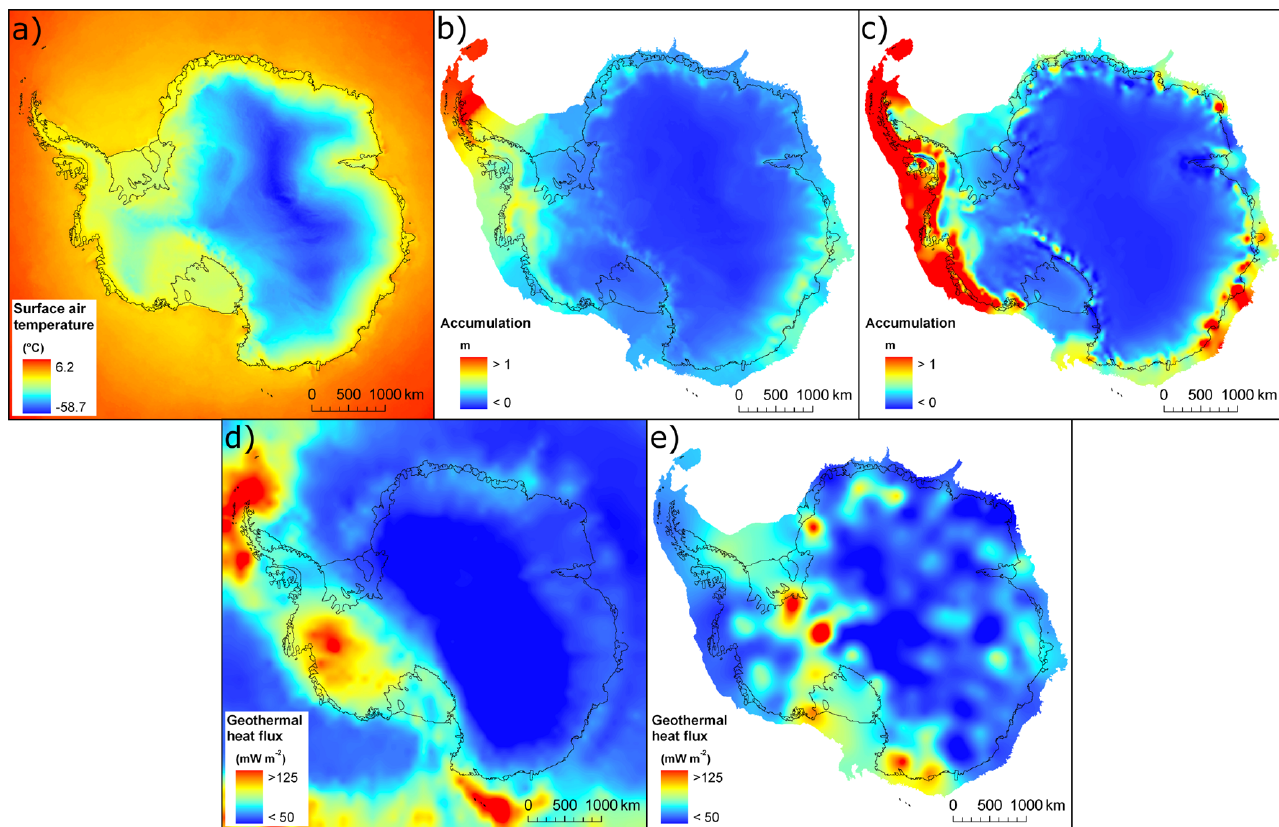
Figure 7. Other datasets provided: (a) surface air temperature, (b) accumulation (Arthern et al., 2006), (c) accumulation (Van de Berg et al., 2006), (d) geothermal heat flux (Shapiro and Ritzwoller, 2004) and (d) geothermal heat flux (Fox Maule et al., 2005).